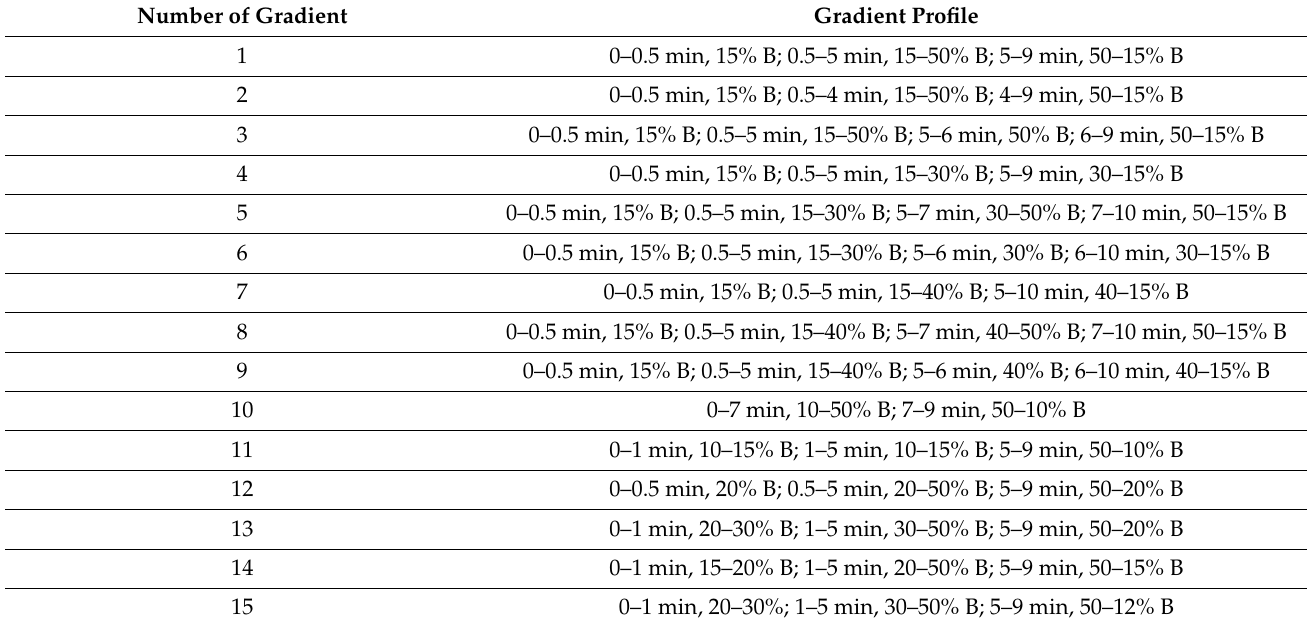
Table 1. Gradient profiles checked during development